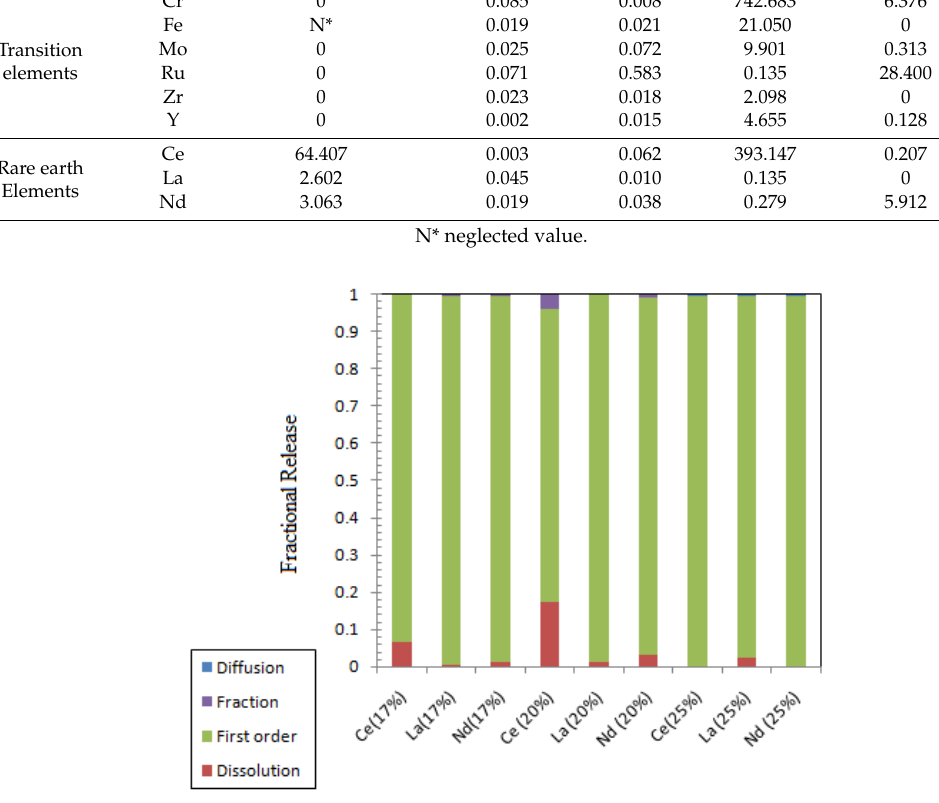
earth elements: ABS-Waste (25).